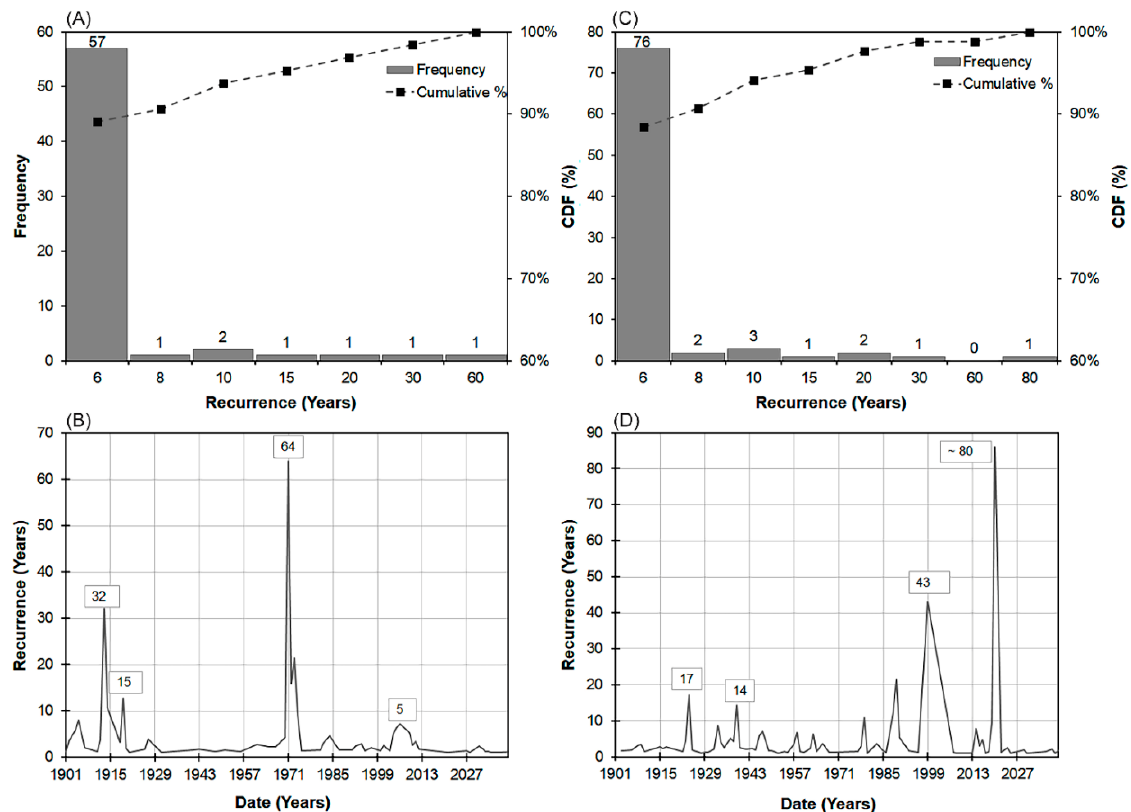
Figure 14. Drought frequency ( A ) recurrence ( B ) and flooding frequency ( C ) and recurrence ( D ) intervals between 1901– 2050.